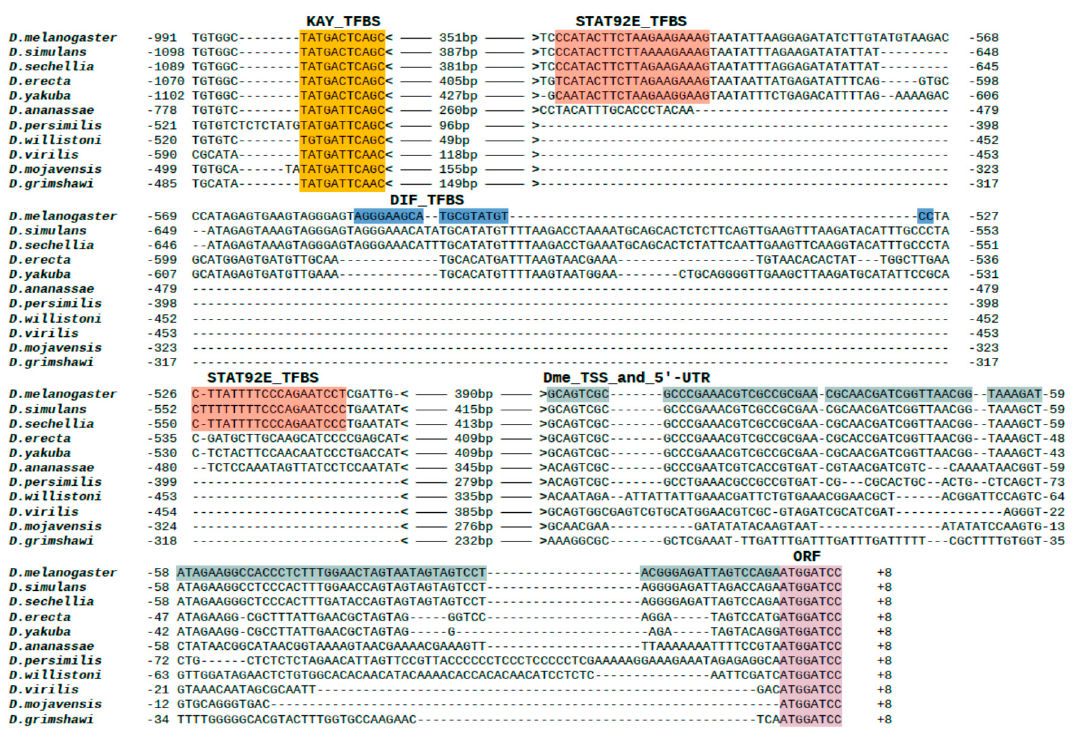
Figure 8. Alignment of Gagr promoter regions for different Drosophila species. Features marked in color: TFBS –Transcription factor binding sites; Dme_TSS_and_5’-UTR—Transcription start site and 5’-untraslated region of D. melanogaster Gagr ; ORF – Open reading frame.